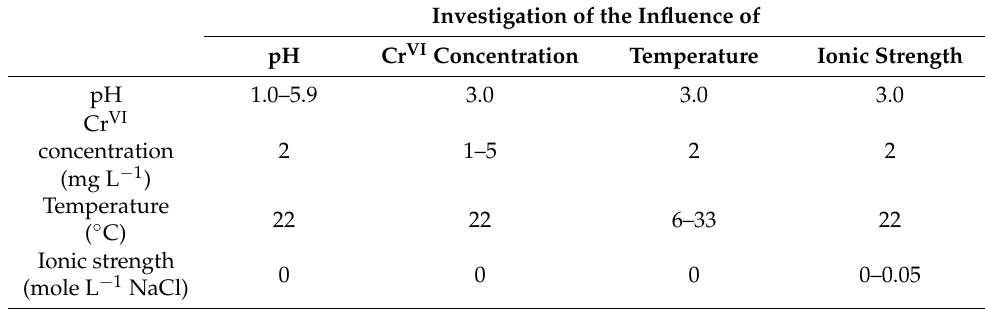
Table 4. Setup design of Cr VI treatability experiments